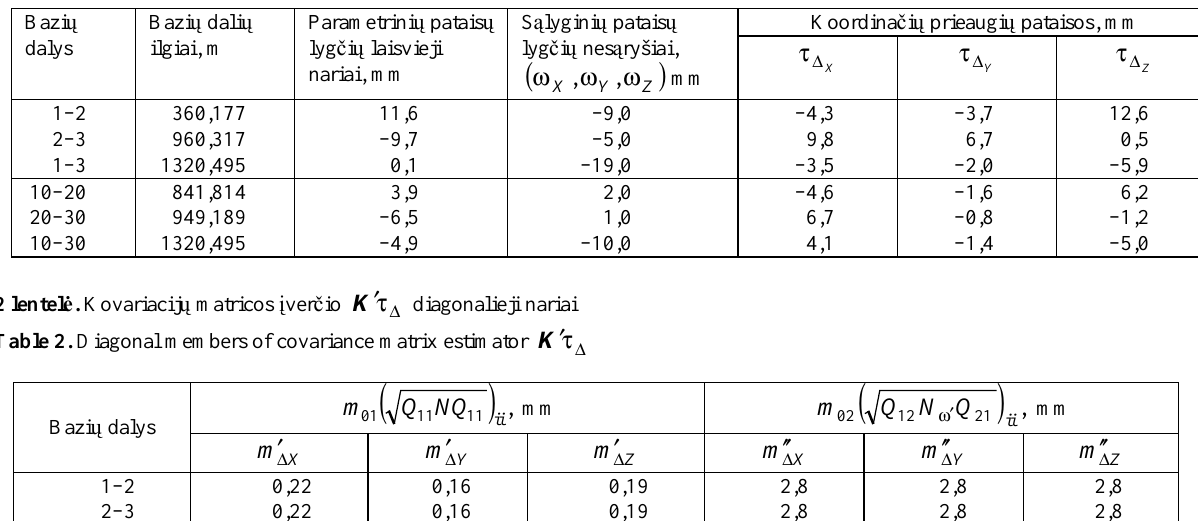
Table 1. Values of the coordinates discrepances corrections